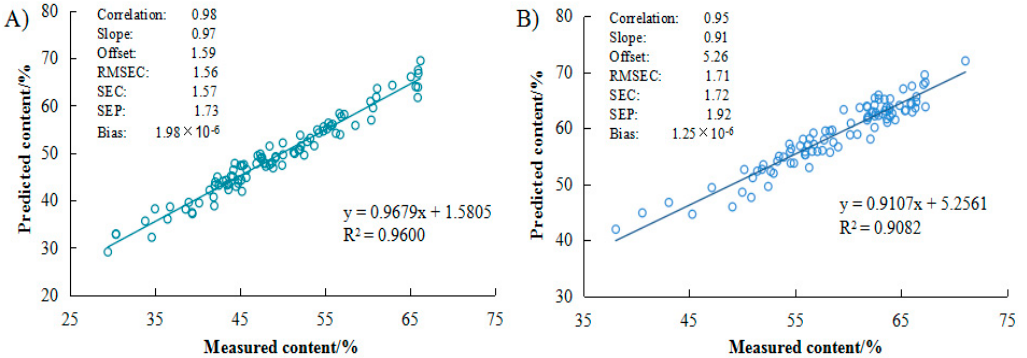
Figure 3. Scatter plots of measured versus predicted oil content of kernels for the PLS models by NIRS: ( A ) Camellia gauchowensis Chang; and ( B ) C. semiserrata Chi. Thereby, the models by NIRS of C. gauchowensis Chang and C. semiserrata Chi seeds kernels were practicable to predict the oil